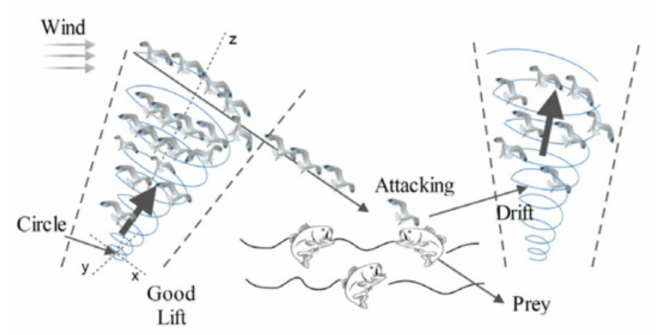
Figure 2. Migration and attack pattern of